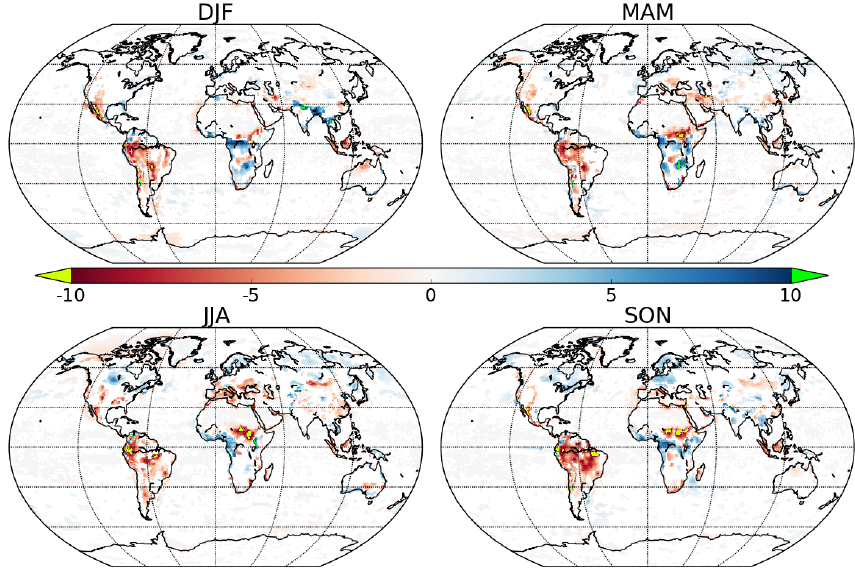
Figure 11. The total change (%) in the mean seasonal formation of dew (mmd − 1 ) over the years 1979–2012 as predicted by the Theil–Sen estimator. Only locations with a statistically significant trend ( p < 0 . 05) are